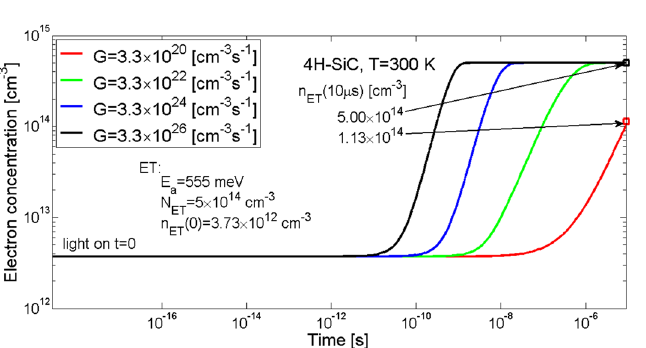
Figure 5. Simulation of rate of change in electron concentration at trap levels SD1 ( a ) and SD2 ( b ) in 4H-SiC material. The green lines show rates of capturing electrons from the conduction band, the red lines show rates of thermal emission of excess electrons from the individual traps to the conduction band, and the black lines are a resultant rate of change in electron concentration as an effect of simultaneous occurrence of the capturing and thermal emission processes. Parameter G is the generation rate coefficient.